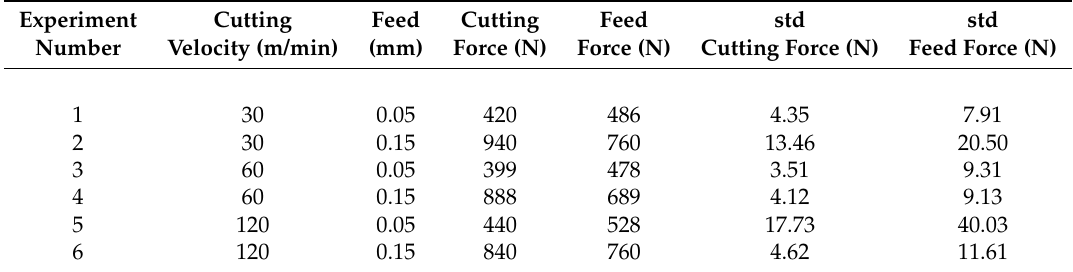
Table 5. Experimental results. std represents the standard deviation.